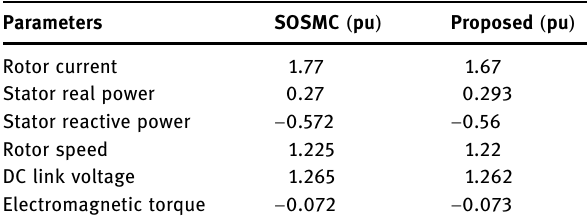
Table 5: Comparison of the proposed controller with SOSMC Parameters